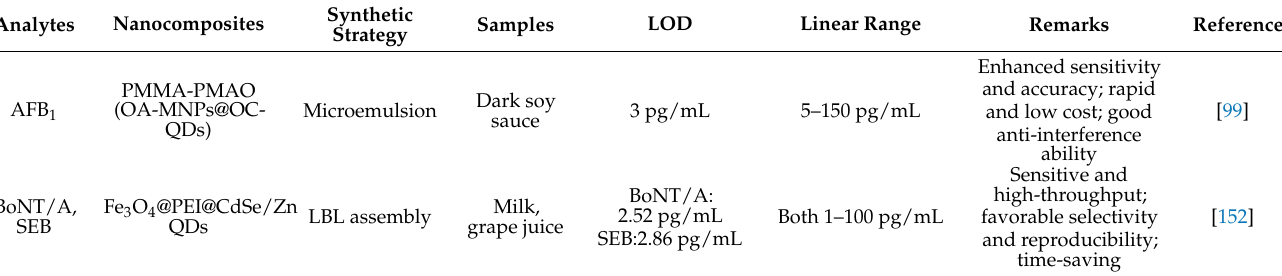
Table 3. Detection performances of MNPs@QDs-based sensors for